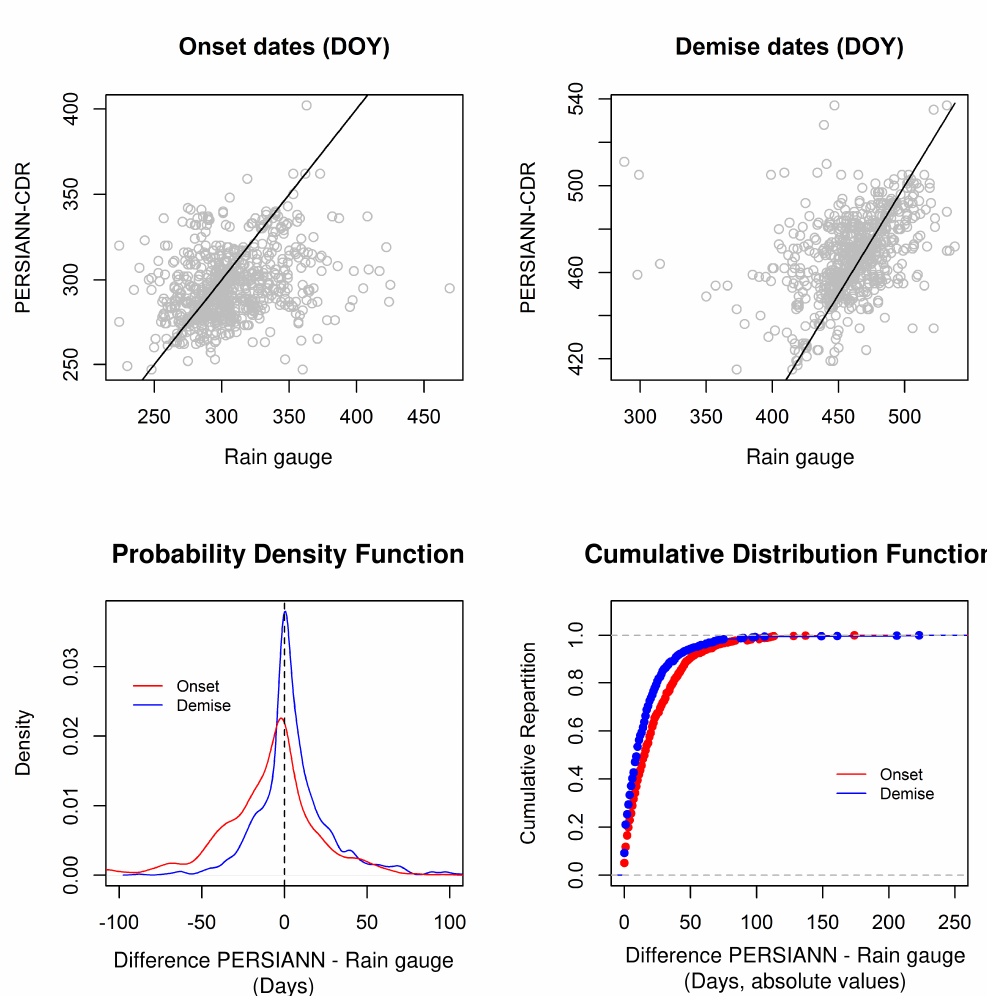
Figure 5. Validation statistics for the onset and demise dates of the rainy season measured by rain gauges and PERSIANN-CDR data. The black line in the two scatter plots represent the identity